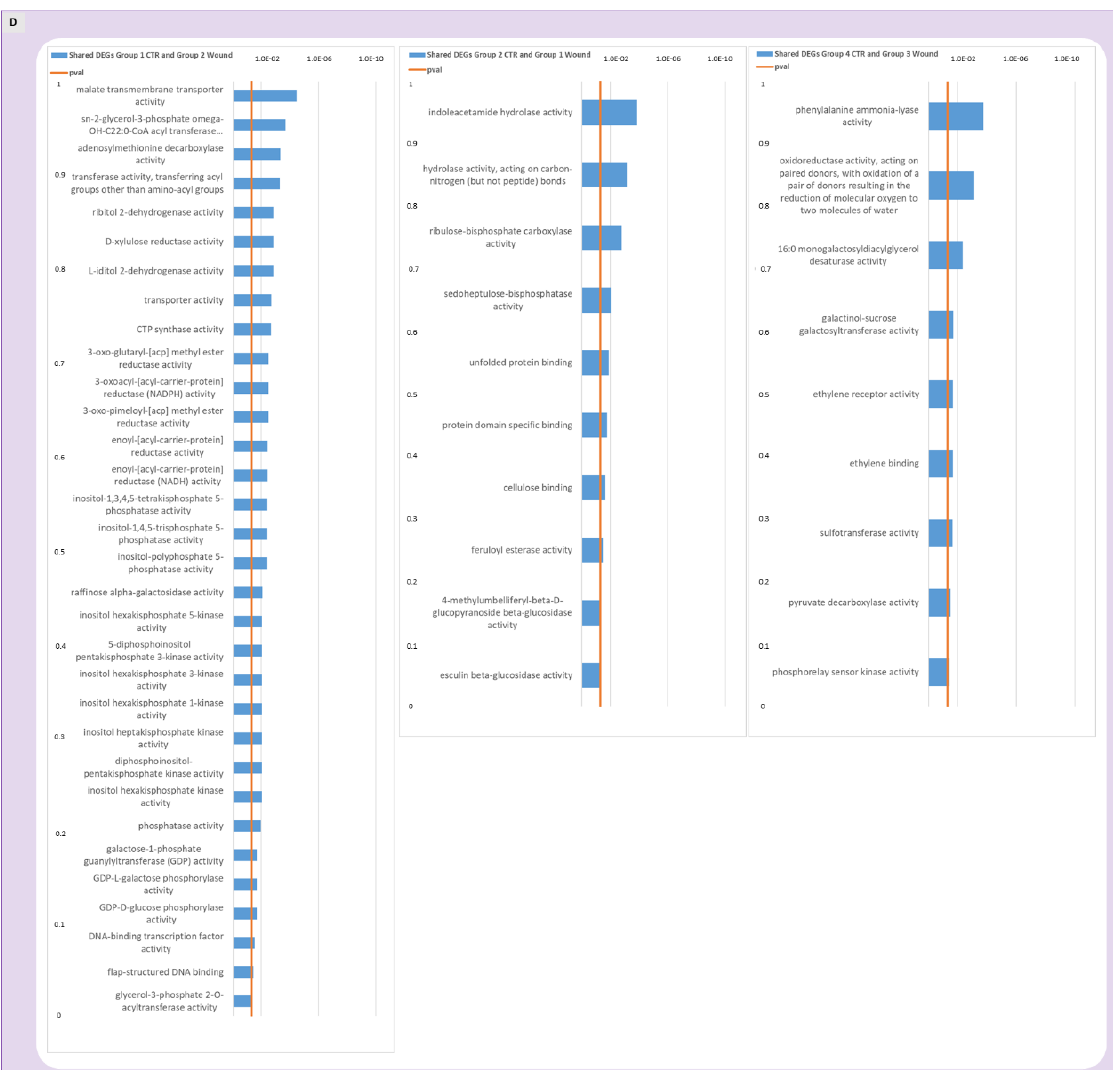
Figure 4. Expression patterns identified for DEGs regulated in control apples over time are shown in panel ( A ) while expression patterns of wounded apples are displayed in panel ( B ). Analogue gene expression patterns for wounded and control apples are shown one on top of another in comparison and Venn Diagrams show the number of genes shared by the two treatments or exclusive for wounded or control apples (panel ( C )). Panel ( D ) shows the GO analysis of genes that were found shared between analogue expression groups in control and wounded apples. The data refer to samples collected in 2019.